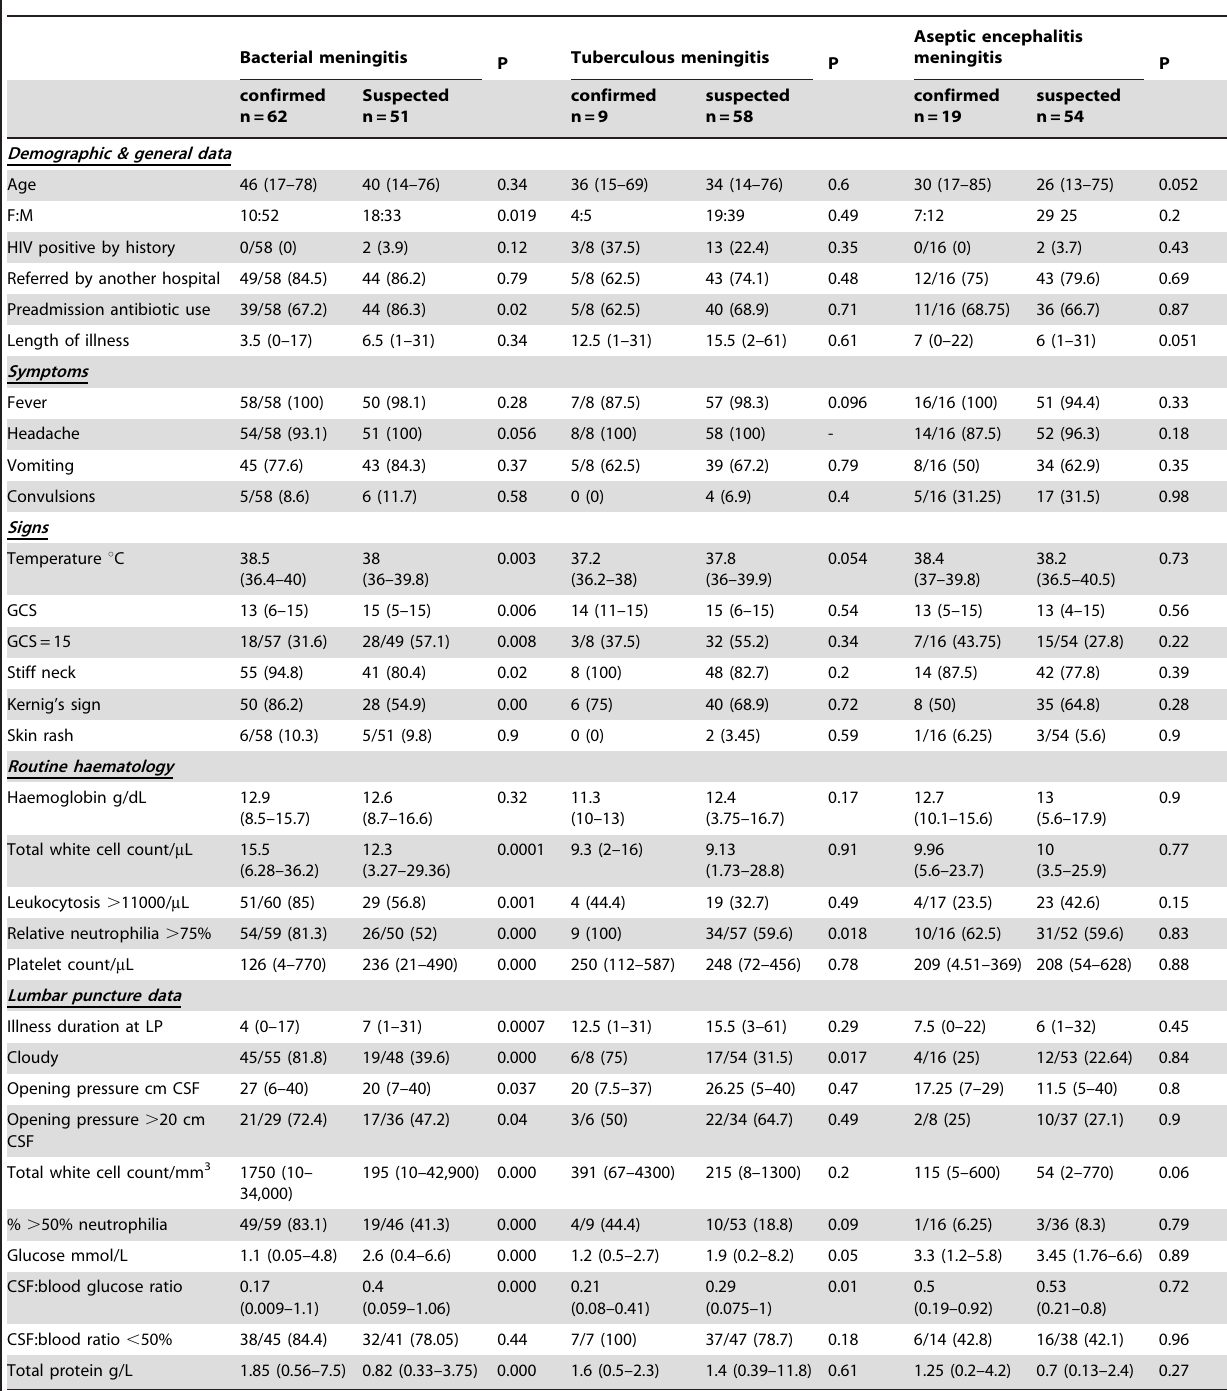
Table 1. Patient demographic, clinical and laboratory features diagnosed with confirmed or clinically suspected bacterial meningitis, tuberculous meningitis and aseptic